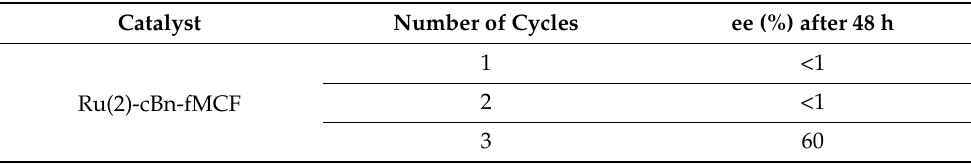
Table 3. Recycling tests of catalyst Ru(2)-cBn-fMCF.